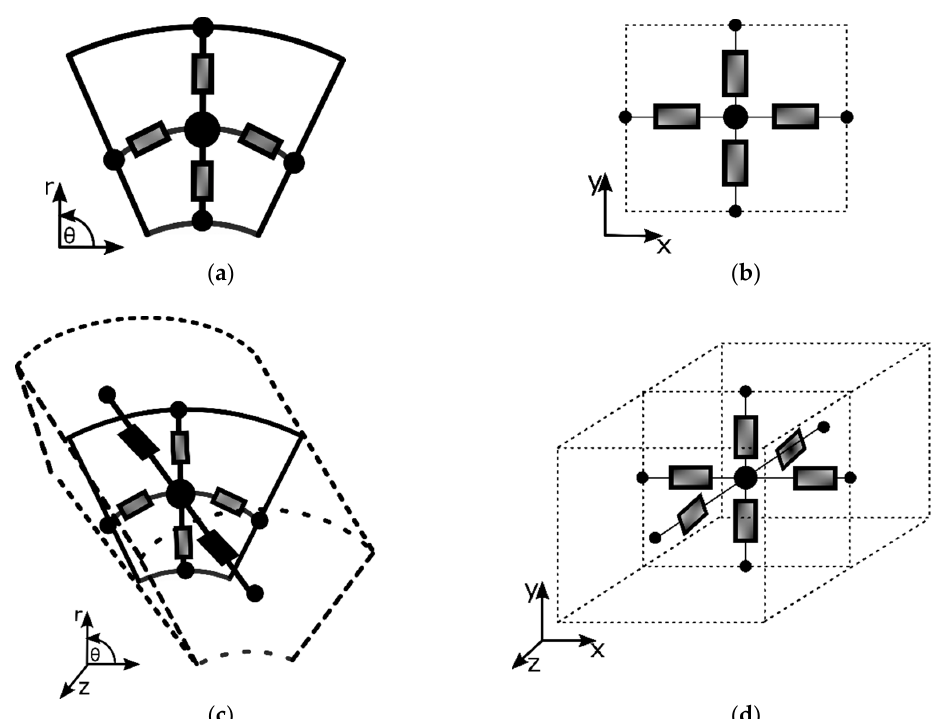
Figure 9. 2D and 3D reluctance block elements. ( a ) Rectangular bidirectional reluctances; ( b ) cylindrical bidirectional reluctances; ( c ) parallelepiped 3D reluctance block element; ( d ) cylindrical tridimensional reluctance block element.